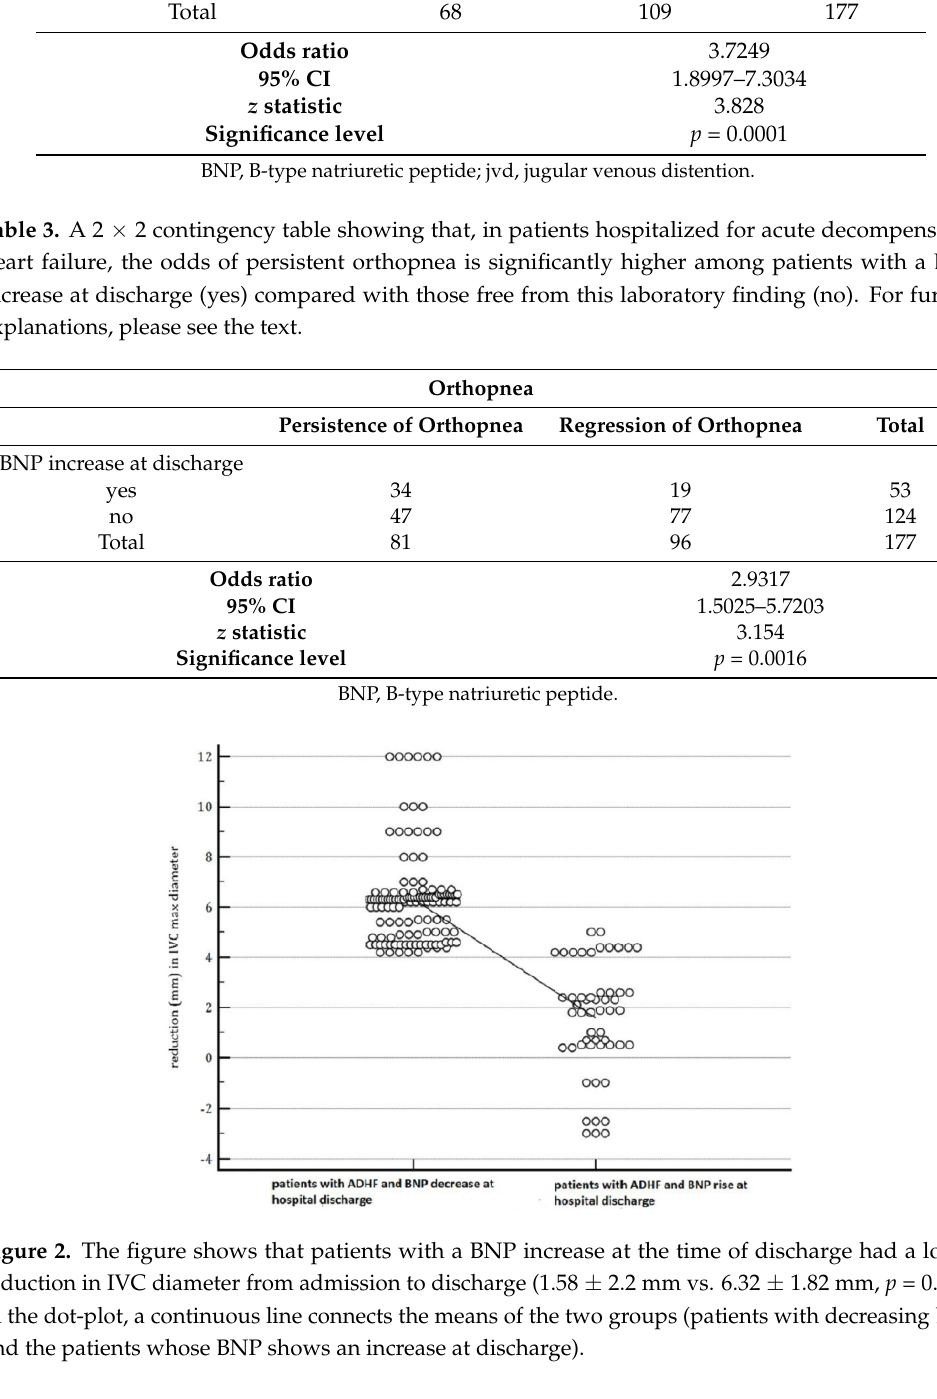
Table 2. A 2 × 2 contingency table showing that, in patients hospitalized for acute decompensated heart failure, the odds of persistent jugular venous distention is significantly higher among patients with a BNP increase at discharge (yes) compared with those free from this laboratory finding (no). For further explanations, please see the text.